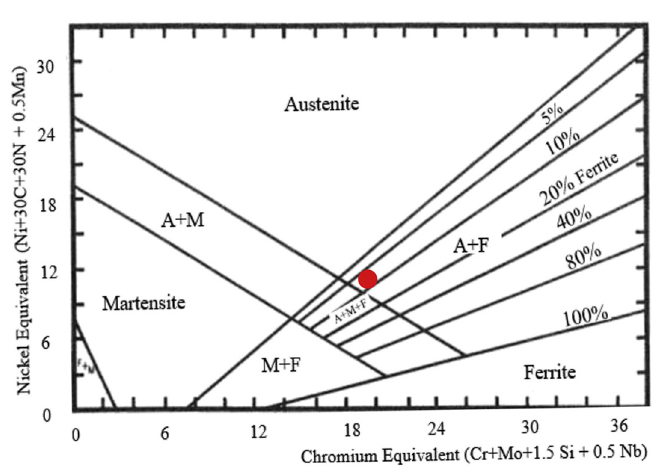
Figure 9. Schaeffler diagram with the 316L point marked [40].